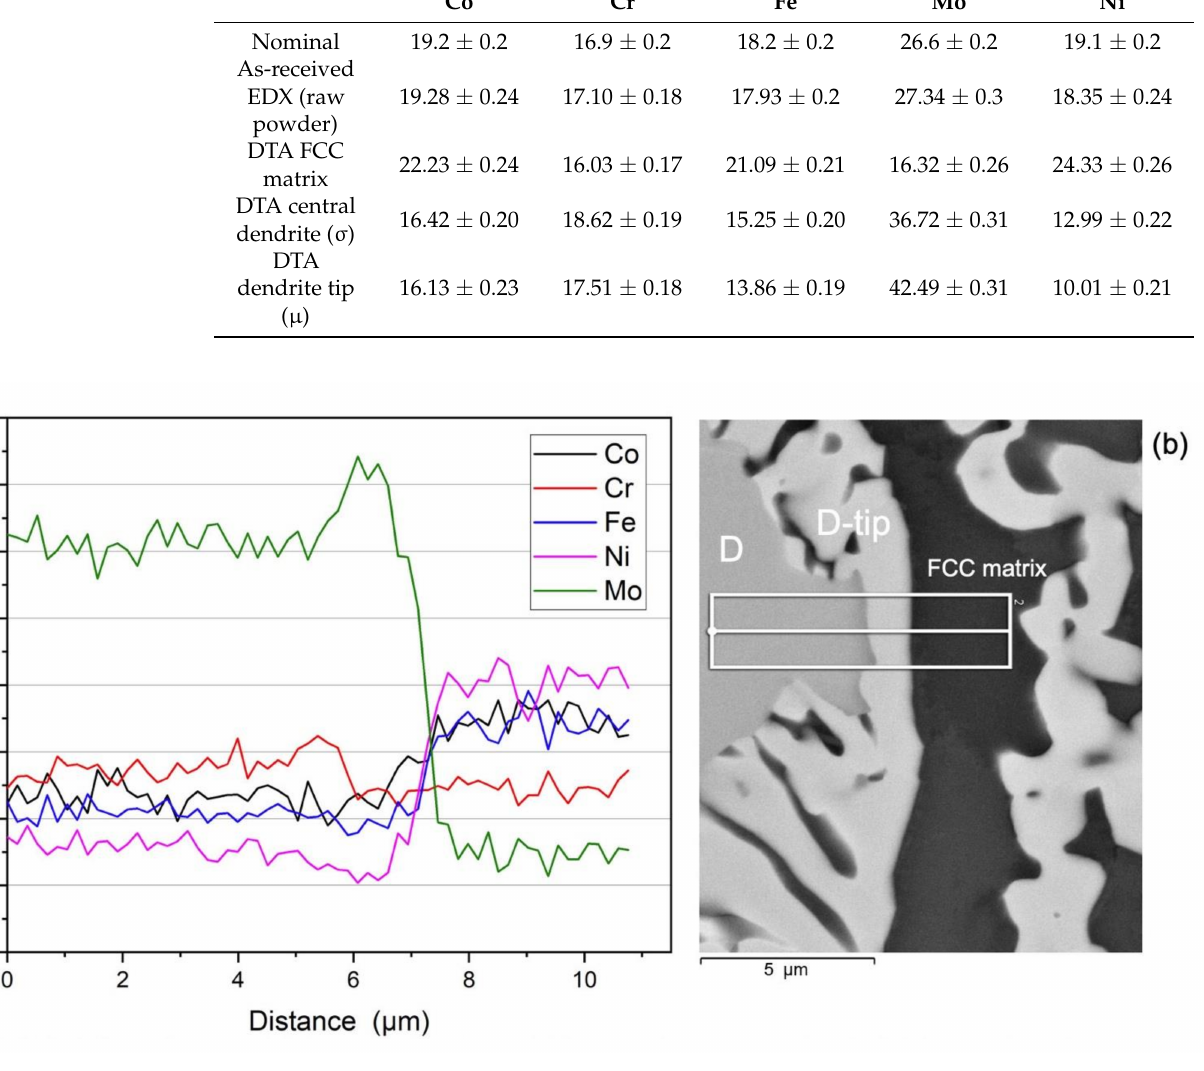
Figure 4. ( a ) Variation of elemental concentration in weight percent, ( b ) backscatterred electron image on scanned site for linescans area across dendrite and interdendrite showing enrichment and depletion of elements among different